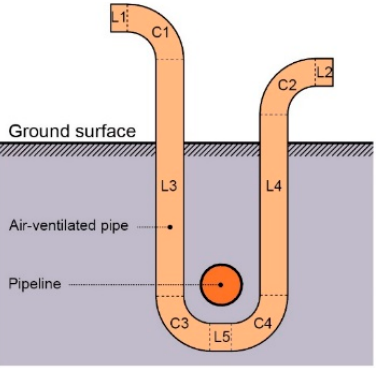
Figure 7. Simplified calculation diagram for the U-shaped air-ventilated pipe.